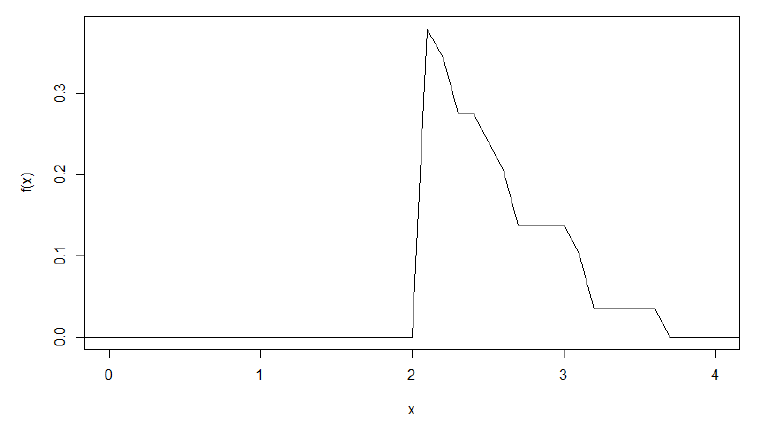
Figure 8. Diagram of function 𝑓(𝑥) for the right border area of positive values